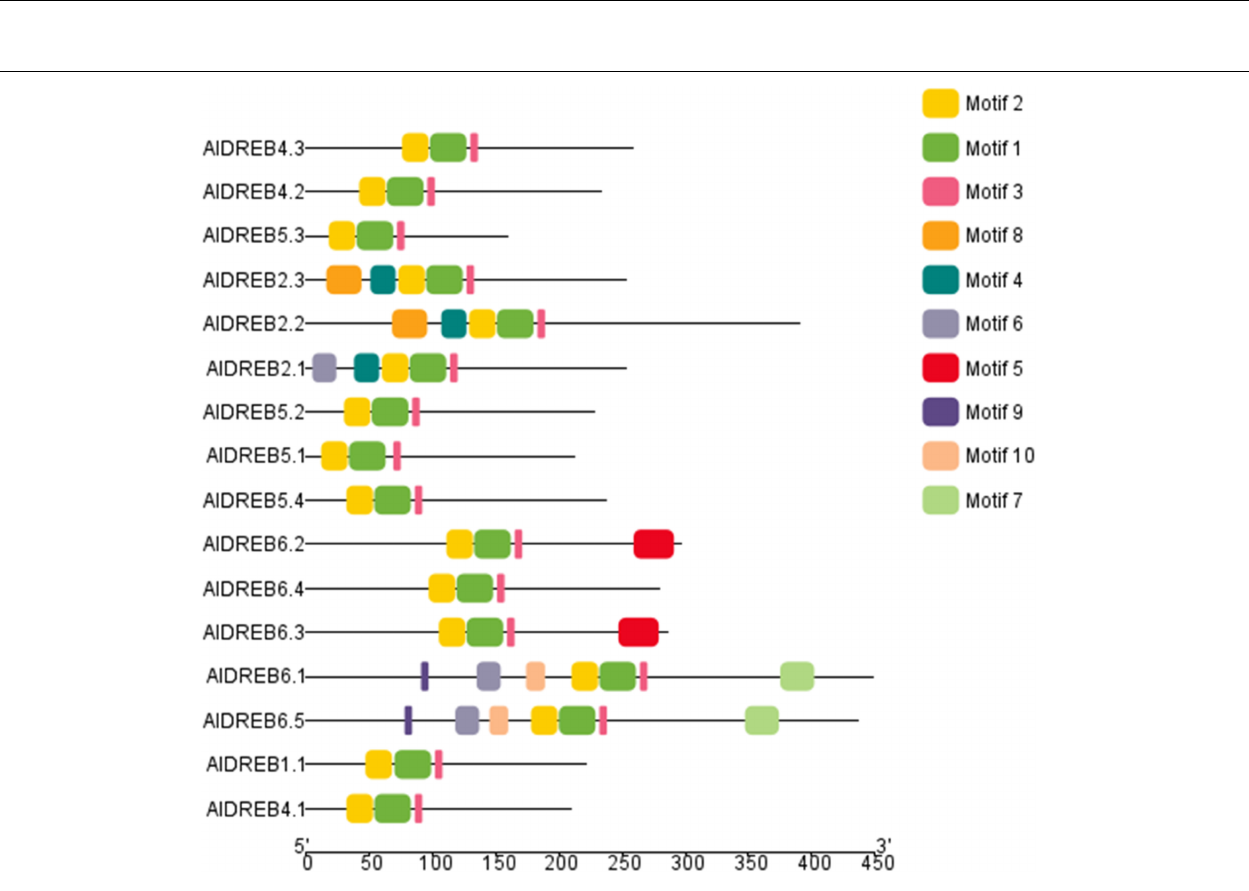
FIGURE 4 | (A) Aeluropus littoralis genome repetitive composition, satDNAs are the most abundant repetitive element within the genome. (B) Dot-plot showing the sequences similarity between the different variants of the same satellite family, AlSat140.